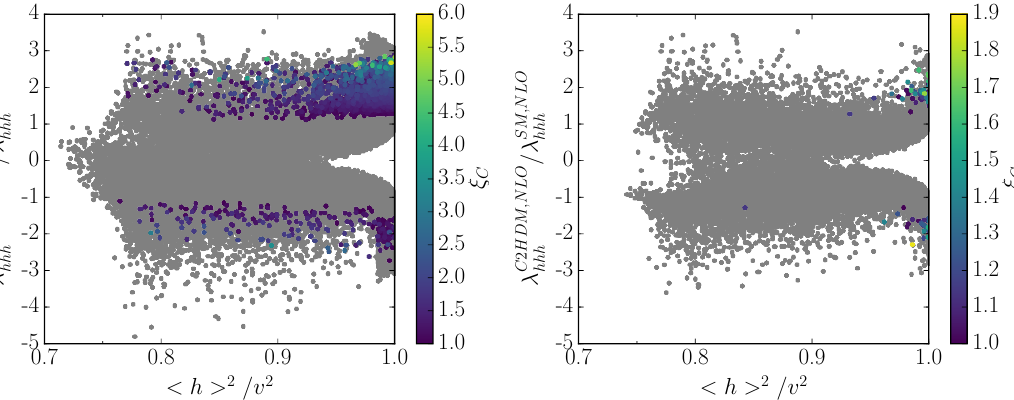
Figure 8 . Type I, H 1 = h : the C2HDM trilinear Higgs self-coupling between three SM-like Higgs bosons h normalized to the SM value, at NLO, as function of the fraction of the VEV squared carried by h . Grey: all points passing the constraints; colour: points with additionally (cid:24) c all 2HDM points; right: only the C2HDM